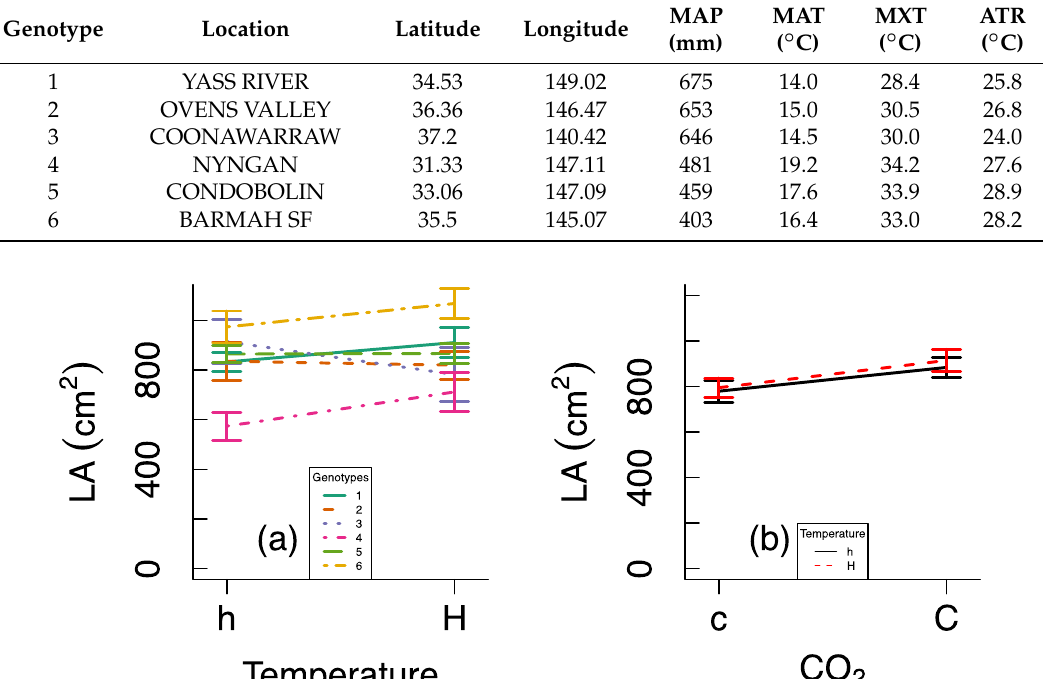
Table A1. Climate of origin for the different genotypes used in this study. For each location, we provide mean annual precipitation (MAP, mm), mean annual air temperature (MAT, °C), mean annual maximum air temperature (MXT, °C), and the mean annual temperature range (ATR, °C) from meteorological station data for the years 1971–2010.